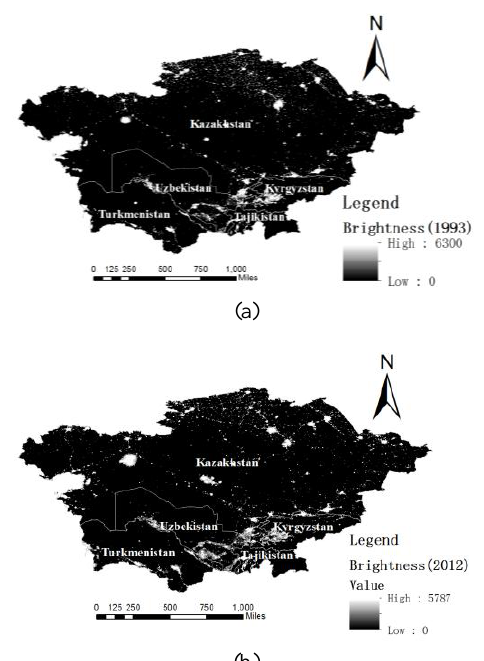
Figure 2. (a) The DMSP/OLS night light imagery of the five Central Asian countries for 1993; (b) The DMSP/OLS nighttime light imagery from the five Central Asian countries